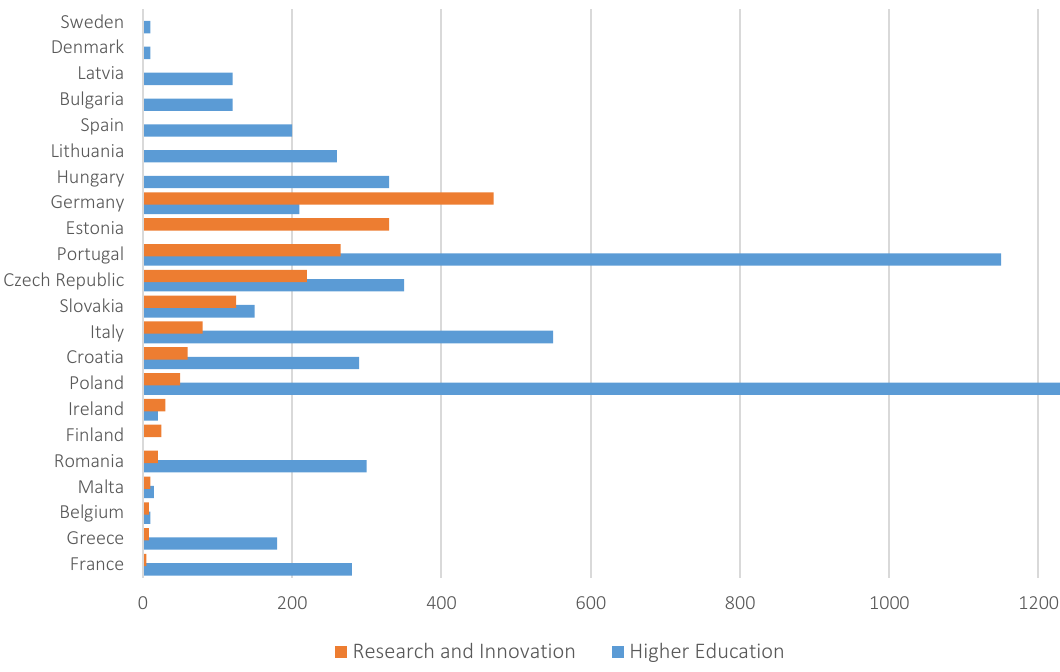
Source: Formed by the authors on the basis of European Commission report